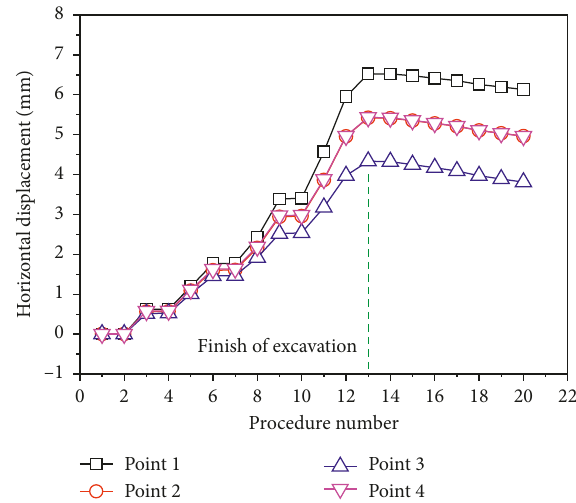
Figure 13: Horizontal displacement of the tunnel structure in scheme 1.